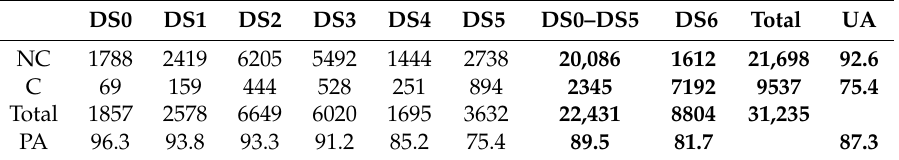
Table 4. Accuracy evaluation of the classification results for collapsed and non-collapsed buildings